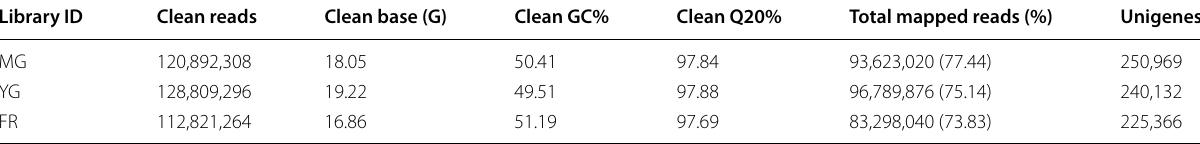
Table 1 Throughput and quality of strand specific RNA-seq of the three libraries Library